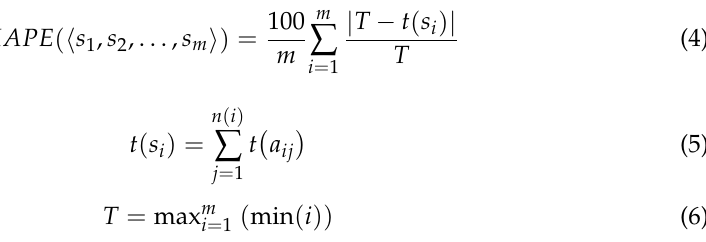
Figure 7. Example of the crossover